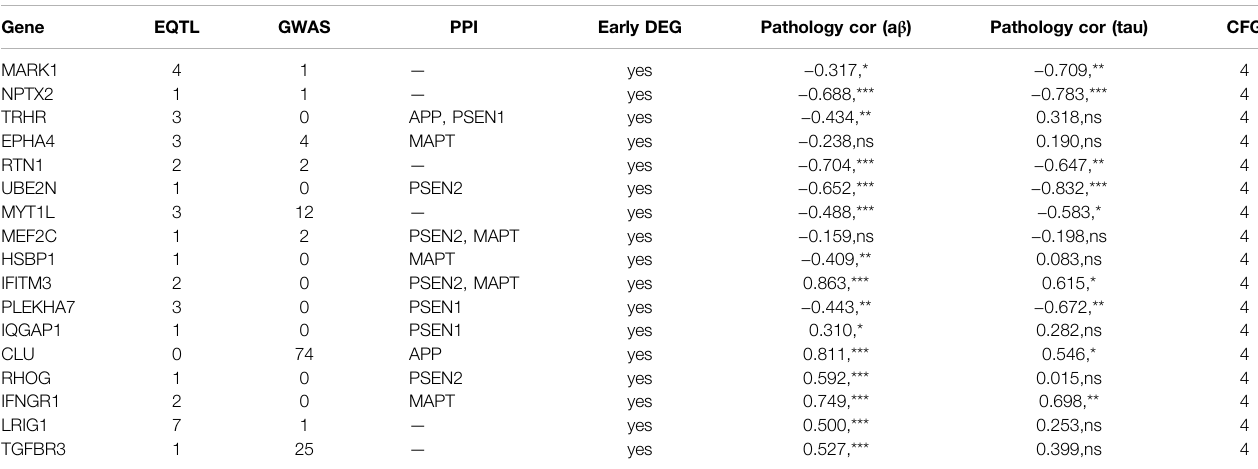
— yes 1 25 — yes eQTL, expressional quantitative trait loci; GWAS, genome-wide association study; DEG, differentially expressed gene; cor, correlation.